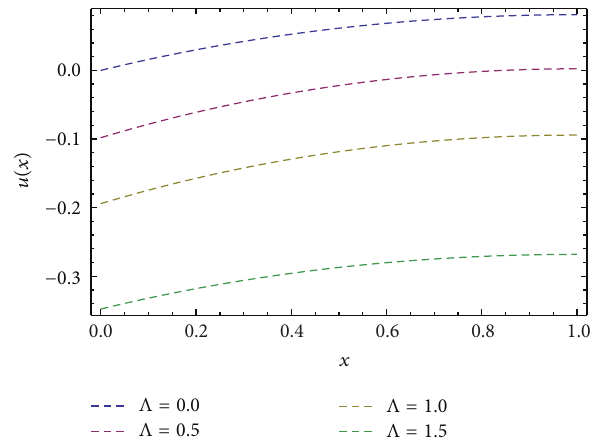
Figure 11: The influence of the magnetic force “ 𝑀 ” on velocity profile shown in this figure for the drainage problem, where 𝑚 = 0.5 , 𝛽 = 1 , and Λ = 0.2 .